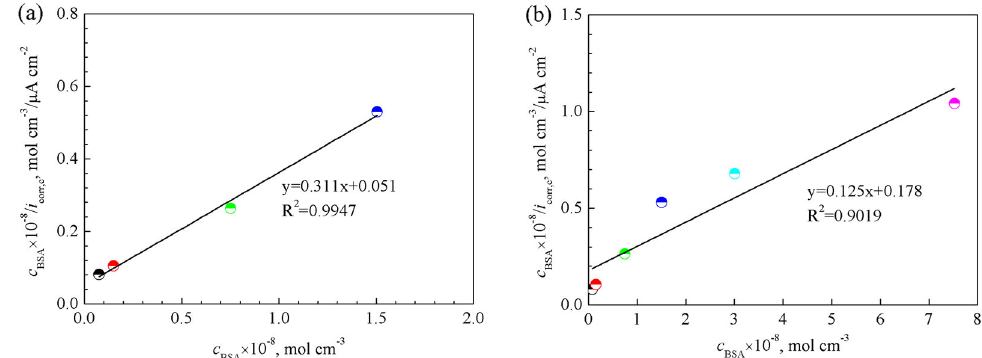
Fig. 6 Langmuir adsorption isotherm of BSA on the pure Zn surface. a BSA concentration ranges from 0 to 1 g L − 1 and b BSA concentration ranges from 0 to 5 g L − 1 . The unit of BSA concentration (g L − 1 ) was transferred into mol cm −